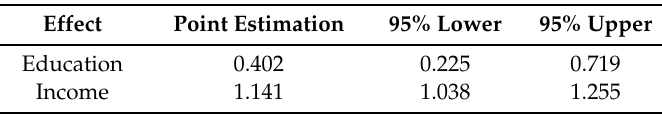
Table 9. The occurrence